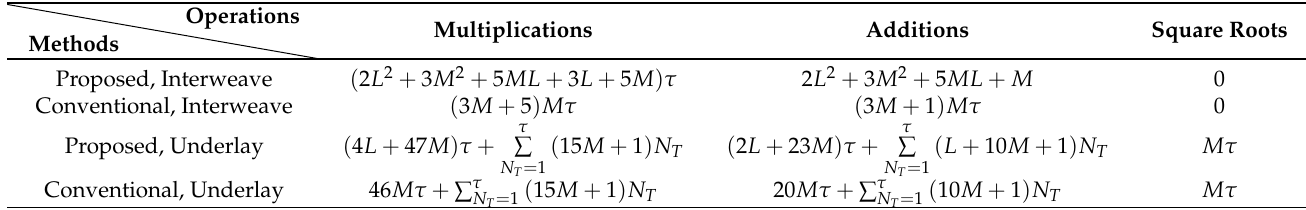
Table 1. Comparison of the computational